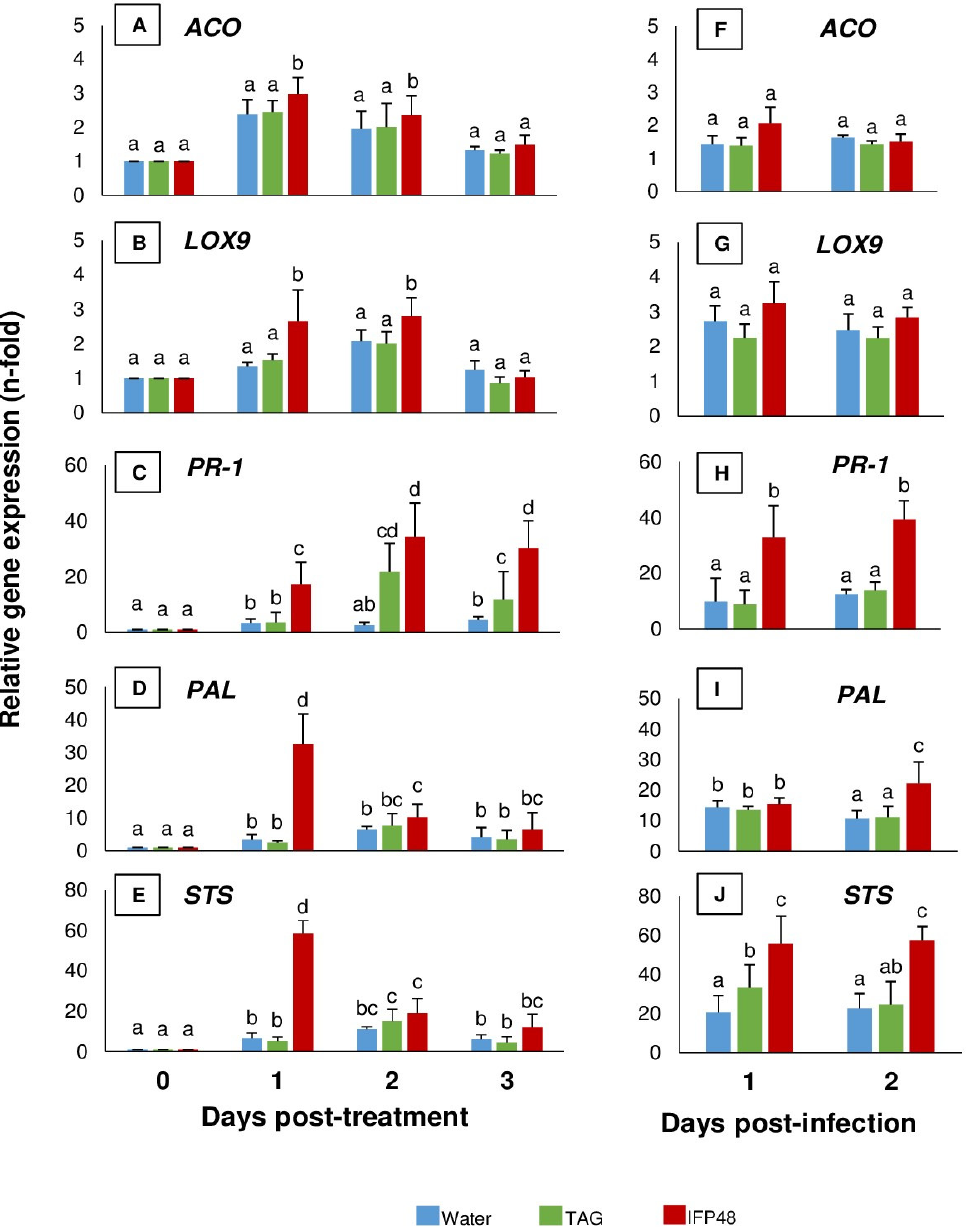
Figure 5. Effects of IFP48 and D-tagatose on relative expression of defense-related genes. Grapevine plantlets were treated with water, 5 g/L D-tagatose-based formulated product (IFP48), or 5 g/L pure D-tagatose (TAG) and leaf samples were collected before ( A – E ) and after Plasmopara viticola inoculation ( F – J ). The expression of genes encoding ACC oxidase ( ACO ), lipoxygenase 9 ( LOX9 ), pathogenesis related 1 ( PR-1 ), phenylalanine ammonia lyase ( PAL ), and stilbene synthase ( STS ) was quantified by qRT-PCR. Data are means ± SD from three independent experiments, each consisted of 18 leaves from six plantlets. Different letters indicate significant differences according to the one-way ANOVA and Tukey’s test ( p ≤